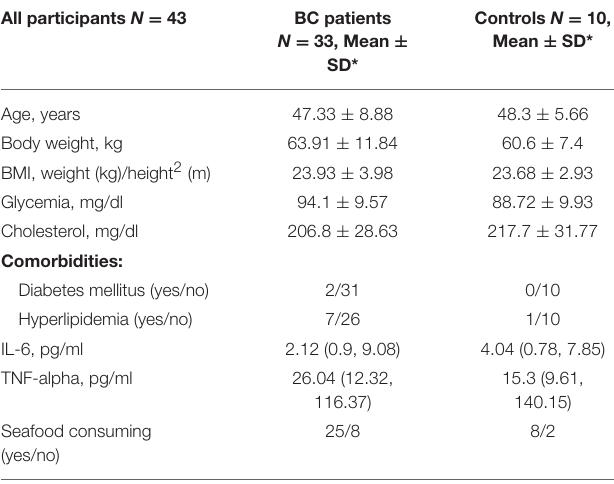
TABLE 1 | Participants’ characteristics. TABLE 2 | DHA levels, EPA levels, and omega-3 index in RBC membranes in the four groups of participants at baseline (T0) and after DHA supplementation (T1).